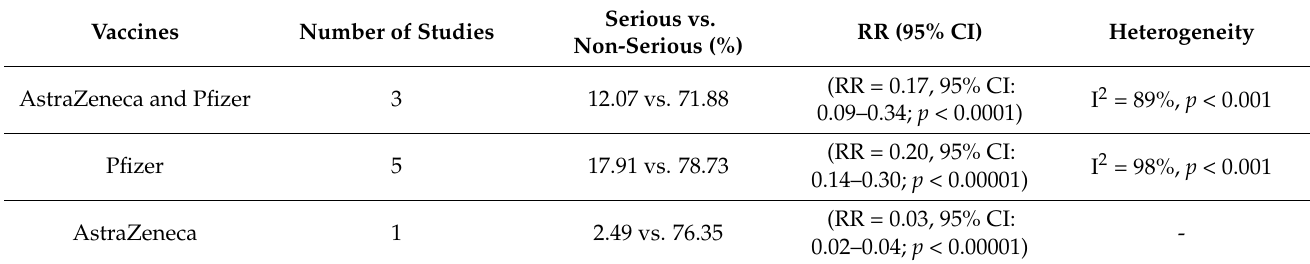
Table 3. Severity of AEs.